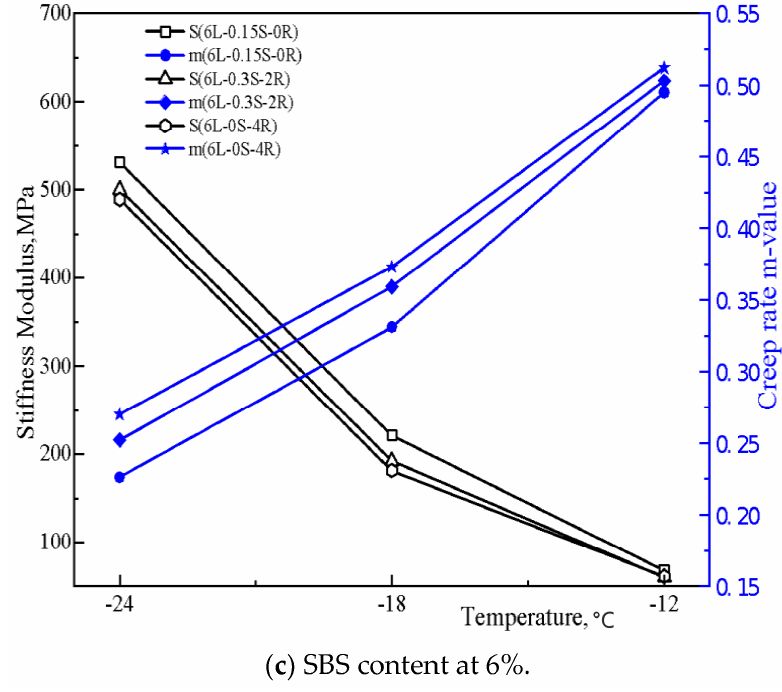
Figure 4. Test results of BBR.